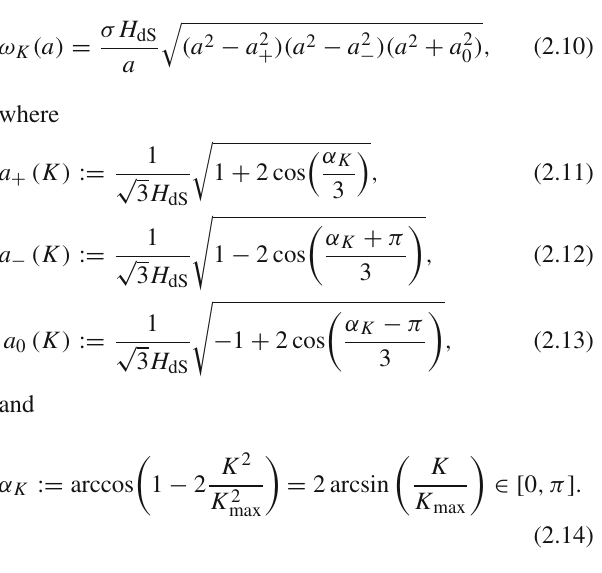
where we have introduced the Planck mass M 2 the ratio γ := ¯ h 2 H 2 to the Planck